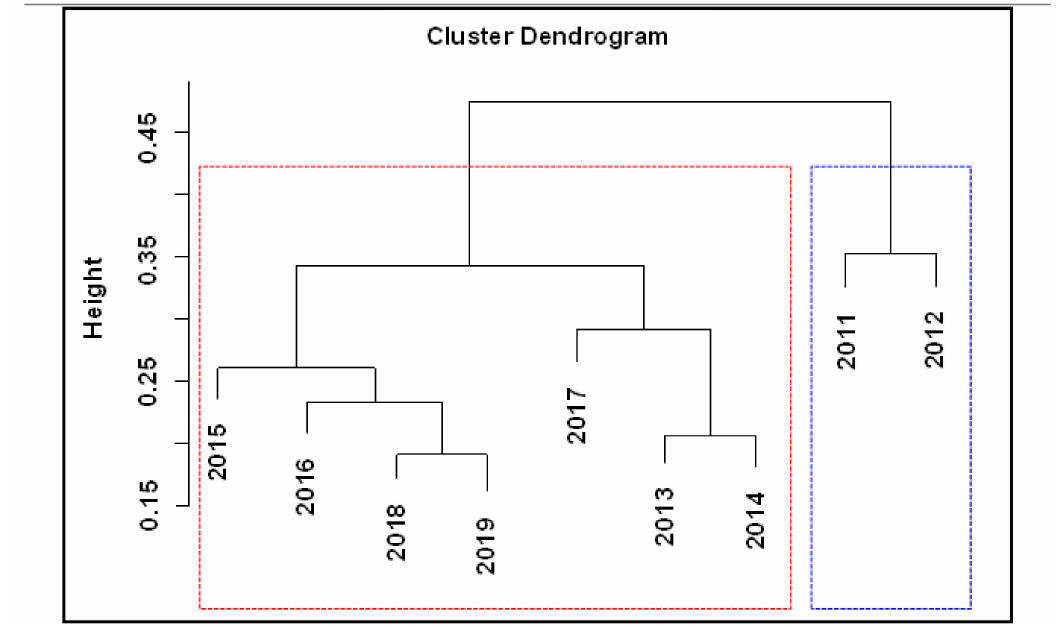
Figure 2. Cluster analysis of fish assemblages in Lake Erhai. Blue boxes represent the first group, red boxes represent the second